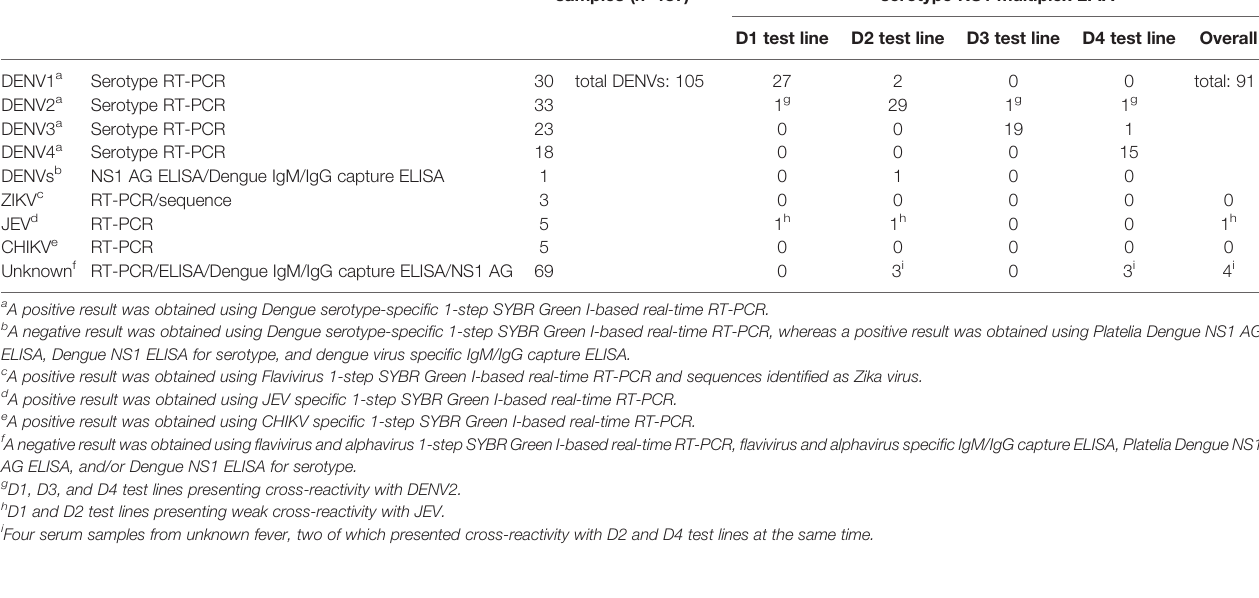
TABLE 6 | Performance of DENV serotype NS1 multiplex LFIA in detection of NS1 in acute-phase sera. Virus Reference